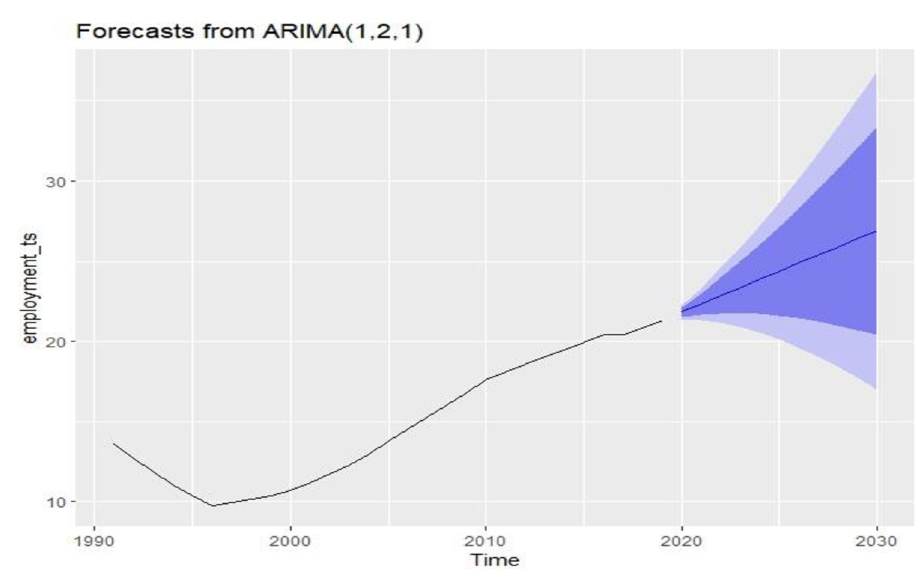
Fig 8. Future condition of employment rate in Bangladesh.